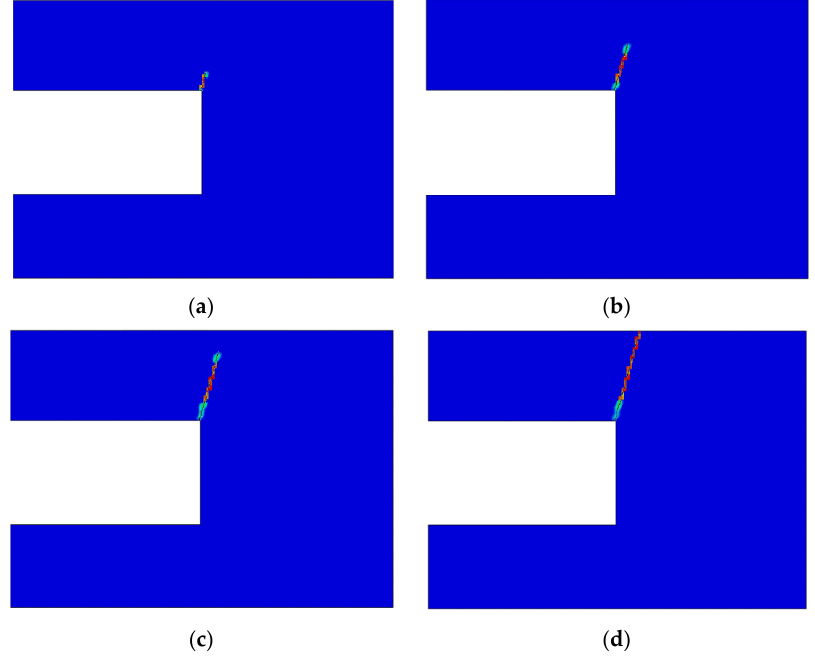
Figure 16. The shield slurry fracturing morphology when the fracturing tip extends to different heights (EK4 + 820). ( a ) 3 m; ( b ) 6 m; ( c ) 9 m; ( d ) 13.5